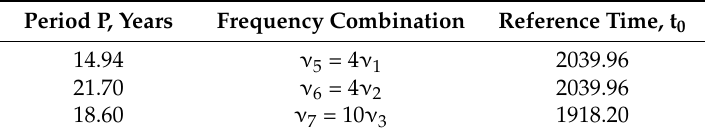
Table 2. Intermediate-period (approximately bidecadal) tidal components derived from three fundamental frequency components that are applied to simulate decadally smoothed GMST residual anomalies. Period P, Years Frequency Combination